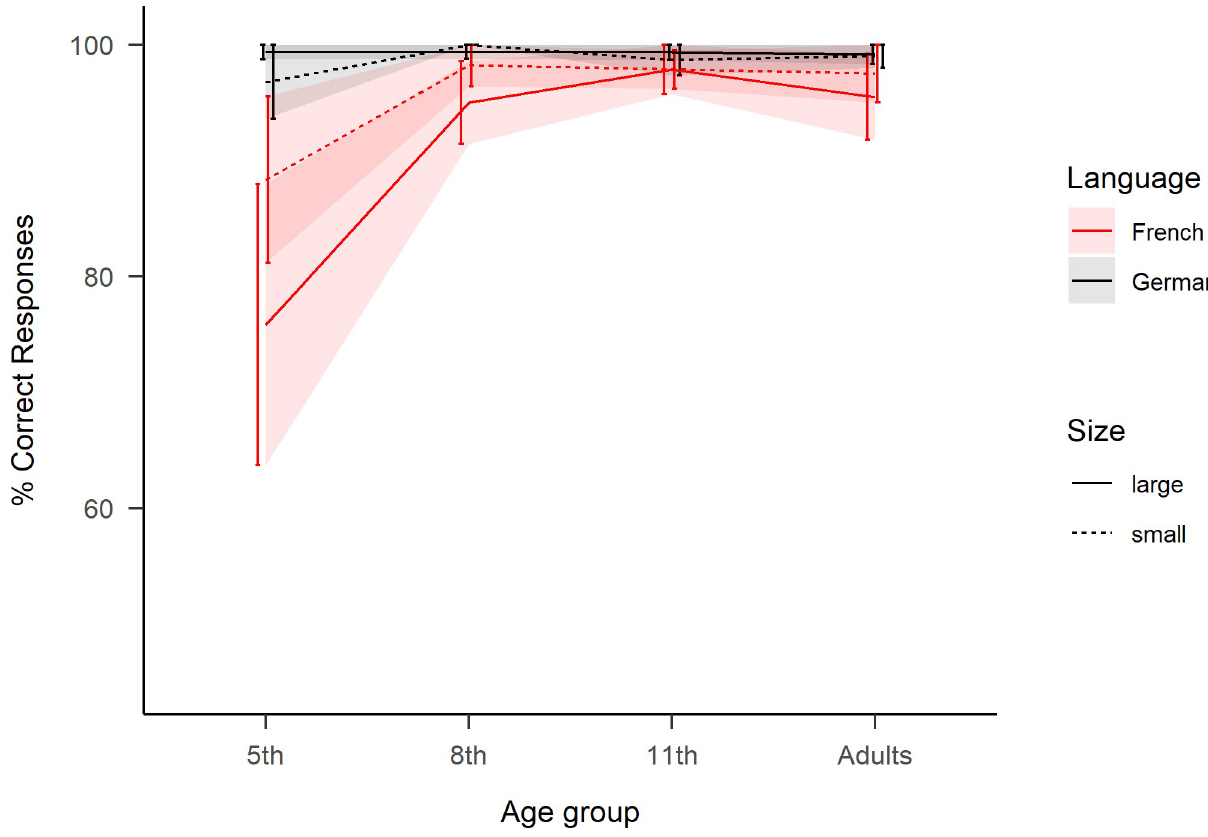
Fig 4. Correct Responses in the reading aloud task. Percent correct for each age group as a function of “Language” and “Number Size”. Large numbers correspond to ‘70s, ‘80s and ‘90s, while small numbers correspond to ‘30s, ‘40s and ‘50s. Ribbons represent standard error.